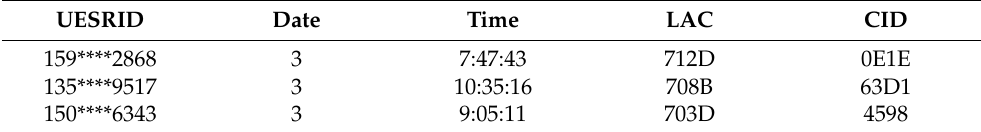
Table 3. Example of mobile phone data structure.